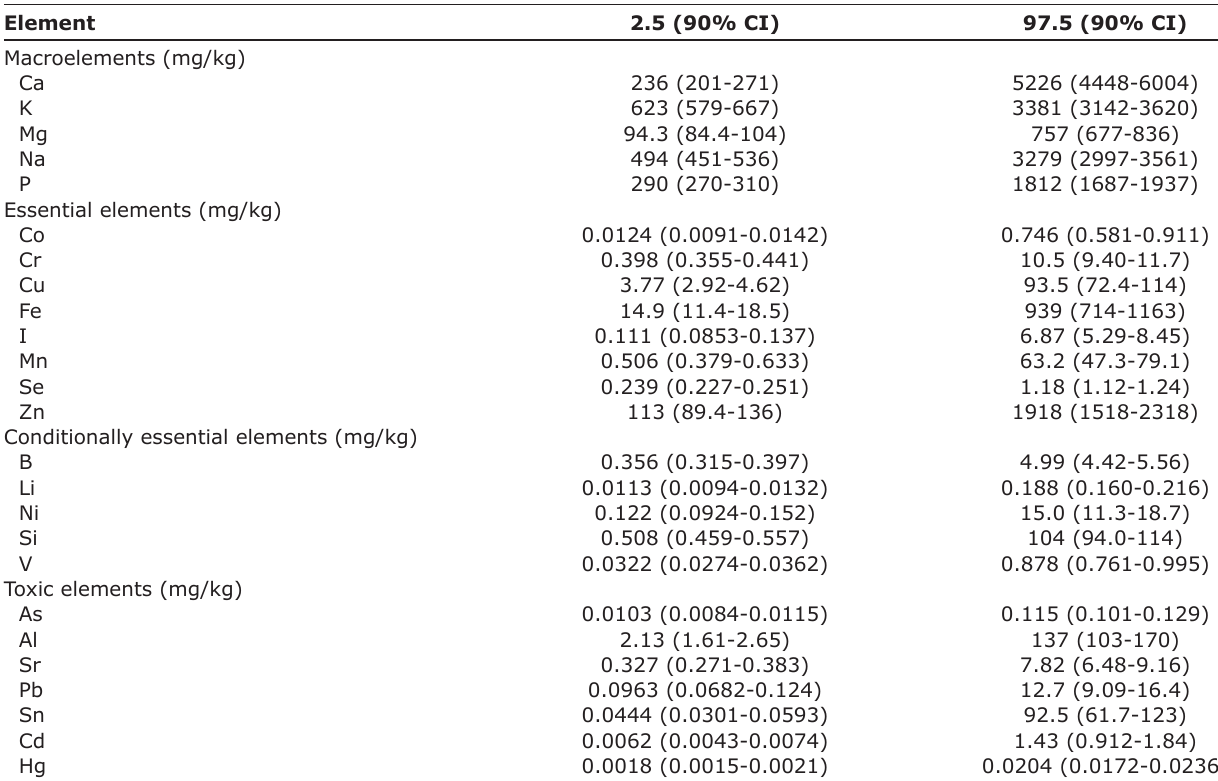
Table-4: Reference ranges of concentrations of essential and toxic elements in laying hens at the age of 20-40 days. Element